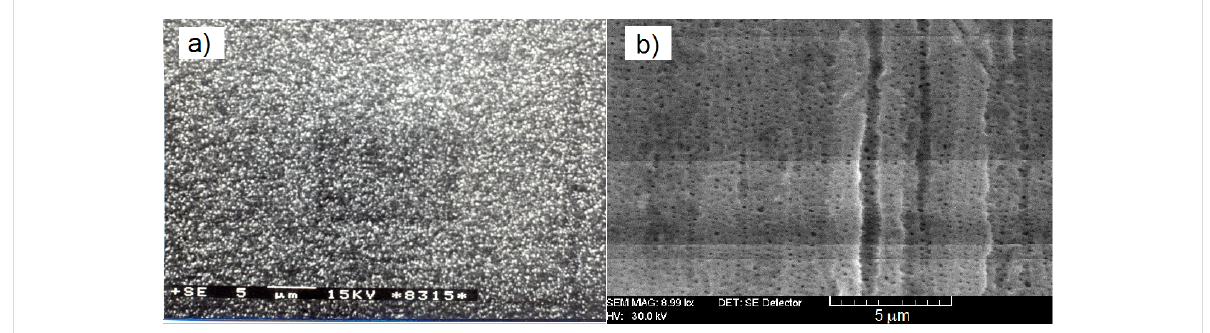
Figure 1: SEM of Te films grown: a) on Pyrex glass at a rate of 10 nm/s and b) on nanostructured Al 2 O 3 substrates at a rate of 30 nm/s. Scale bar is 5 µm.